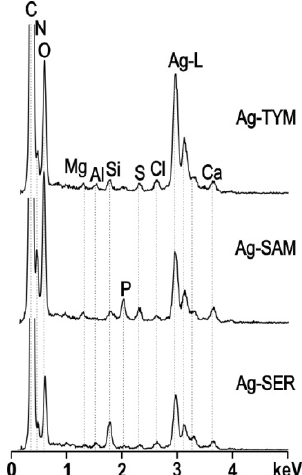
Figure 8. TEM / EDS spectra recorded for the samples with AgNO 3 :plant ratio 1:10. The analyses included both organic matrix and AgNPs.